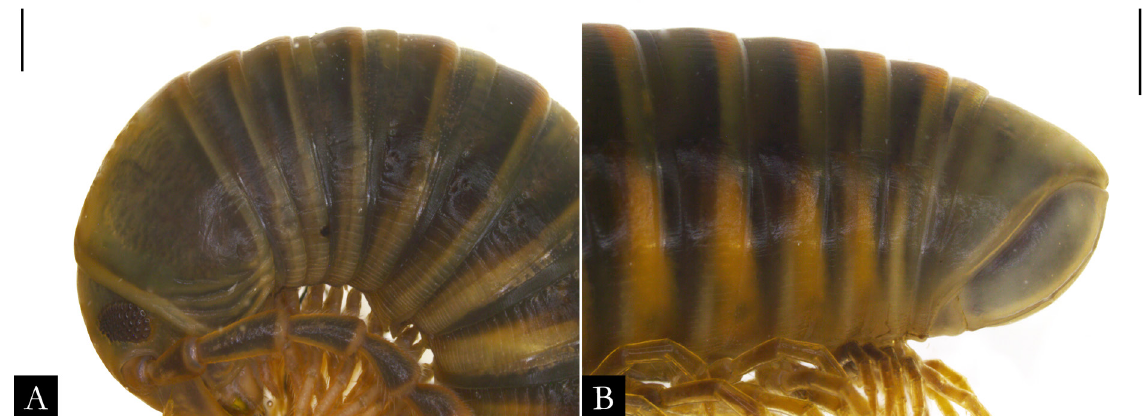
Fig. 58. Pseudonannolene callipyge Brölemann, 1902, ♂ (IBSP 7619), in lateral view. A . Anterior region. B . Posterior region. Scale bars = 1